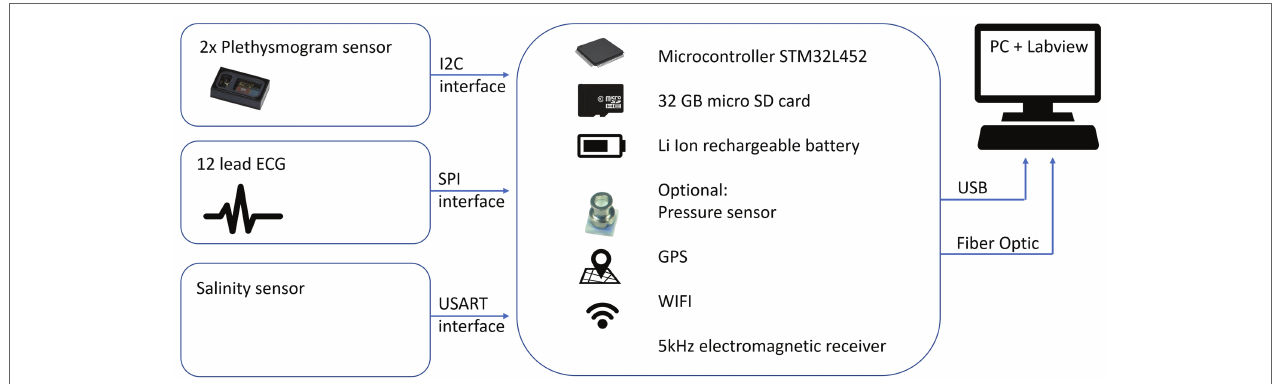
FIGURE 2 | Layout of the technical platform with